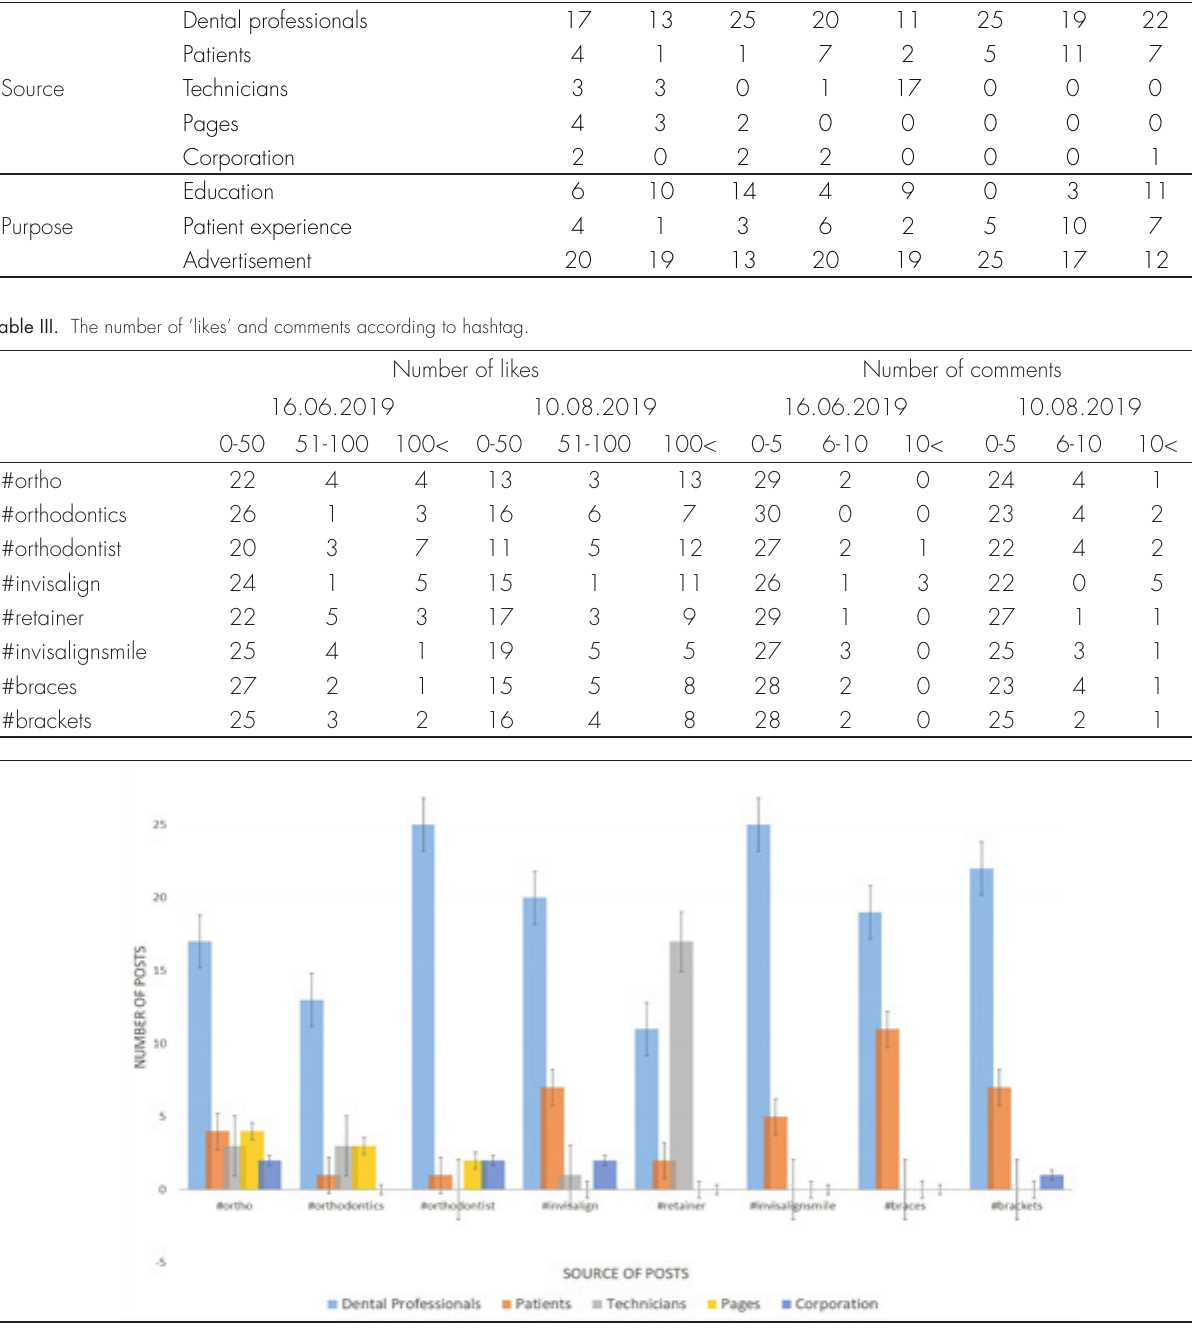
Figure 1. The distributions of the posts according to hashtag